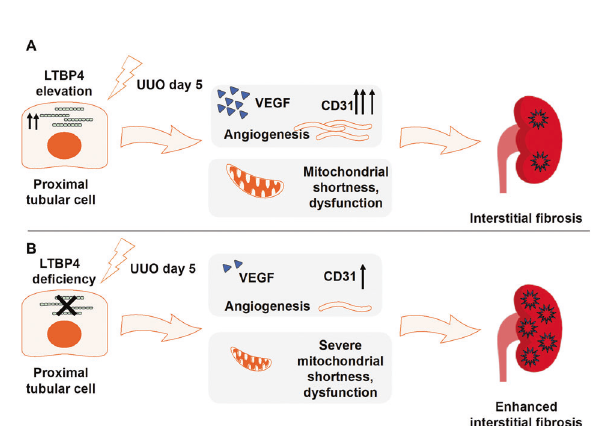
Fig. 7 Proposed model of LTBP4-mediated mechanisms in tubular interstitial fi brosis. In unilateral ureteral obstruction (UUO)-induced tubular damage, A LTPB4 provokes angiogenesis for tissue repair via VEGF and CD31 elevation and in addition to limiting mitochondrial shortness. B LTBP4 de fi ciency in proximal tubules causes a reduction in VEGF and CD31 expression, along with subsequent aberrant angiogenesis and severe mitochondrial shortness, which eventually accelerates tubular interstitial fi